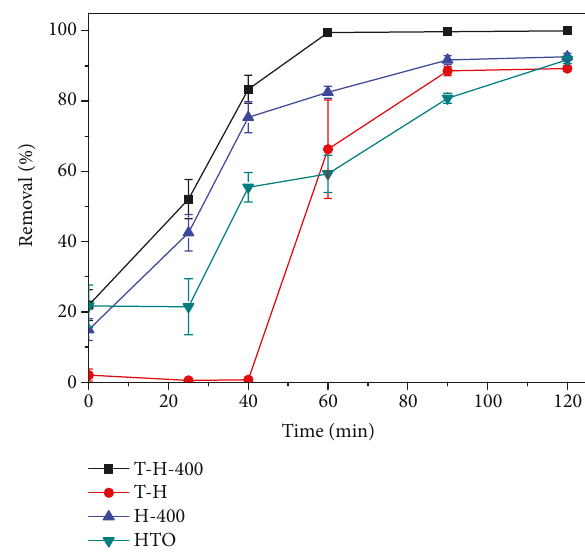
Figure 12: The change of the removal rate of the 2,4-DCP by T-H, T-H-400, H-400, and HTO.